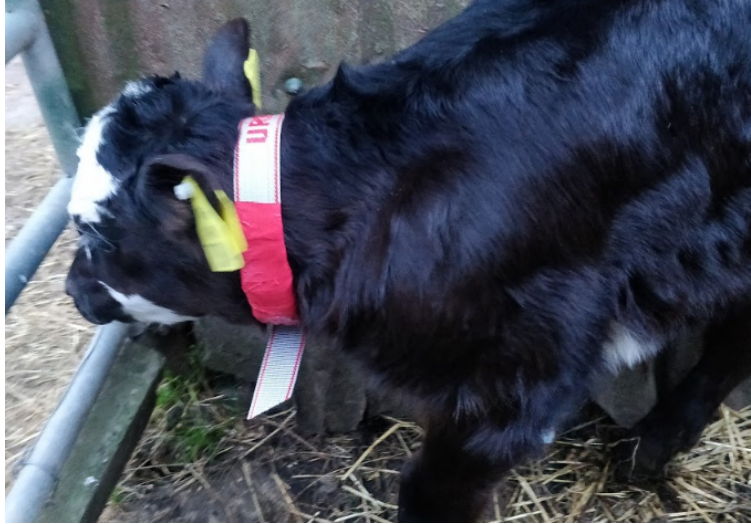
Figure 1. Calf wearing a collar with Axivity AX3 sensor securely